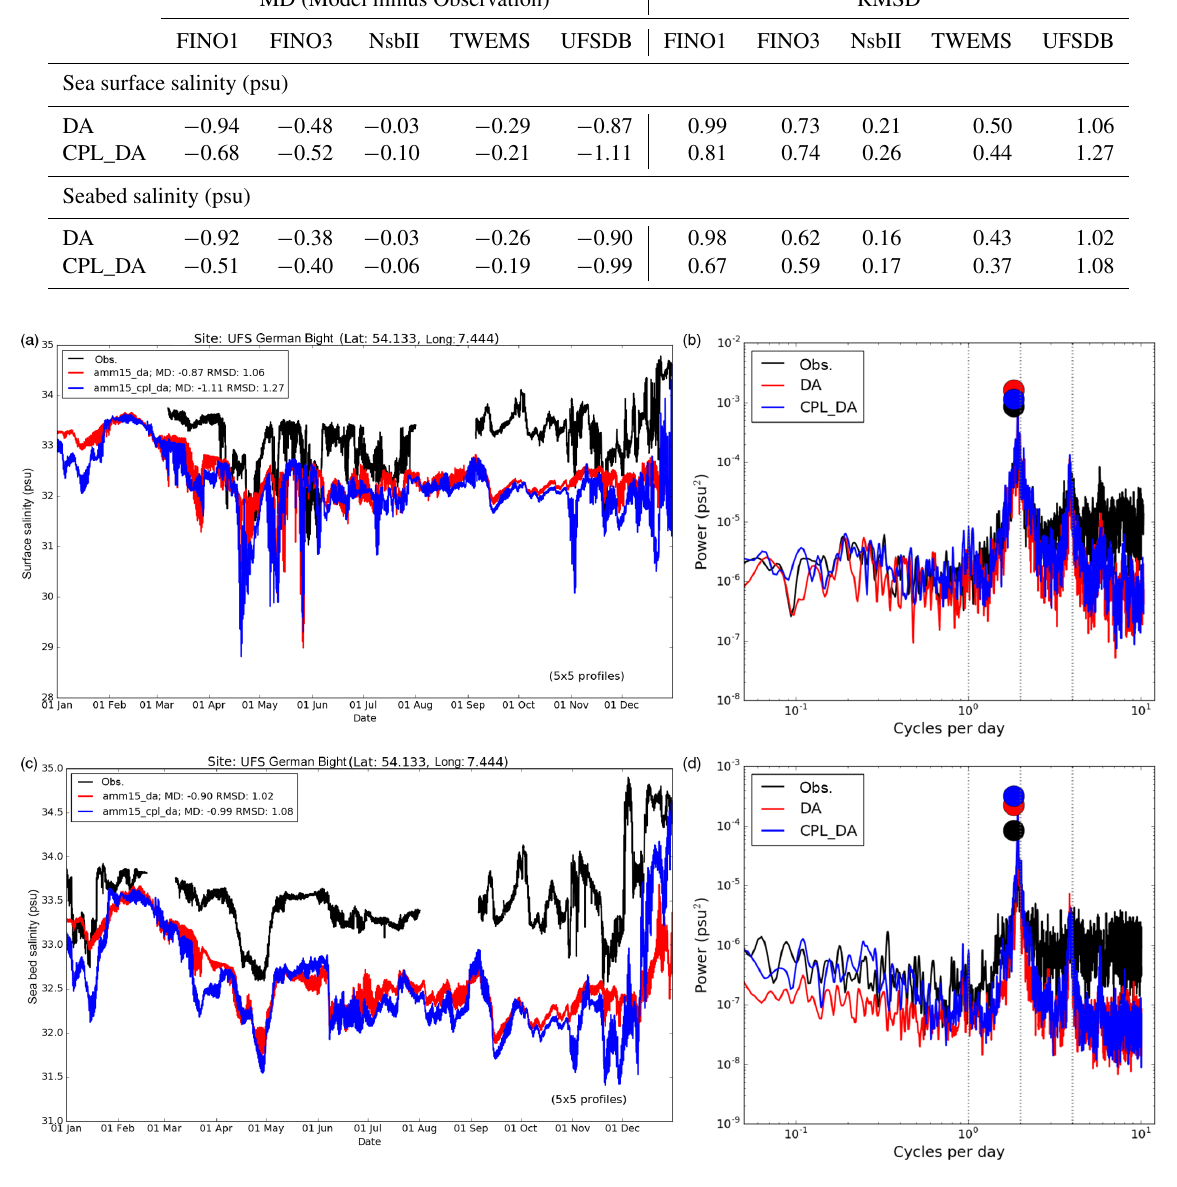
Figure 12. (a, c) Time series of observed and simulated salinity at (a) sea surface (SSS) and (c) seabed (SBS) during 2017 from DA and CPL_DA simulations with observed values in the German Bight (buoy UFSDB). (b, d) Computed power spectra for observed, DA, and CPL_DA simulated SSS and SBS, respectively. Filled circles highlight the amplitude of the peak power for each time series. Vertical dotted lines mark diurnal, semi-diurnal, and quarter-diurnal